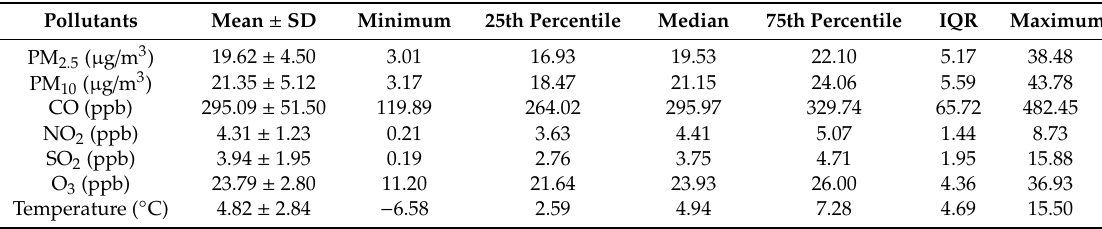
Table 2. Distributions of air pollution and temperature parameters during entire pregnancy,